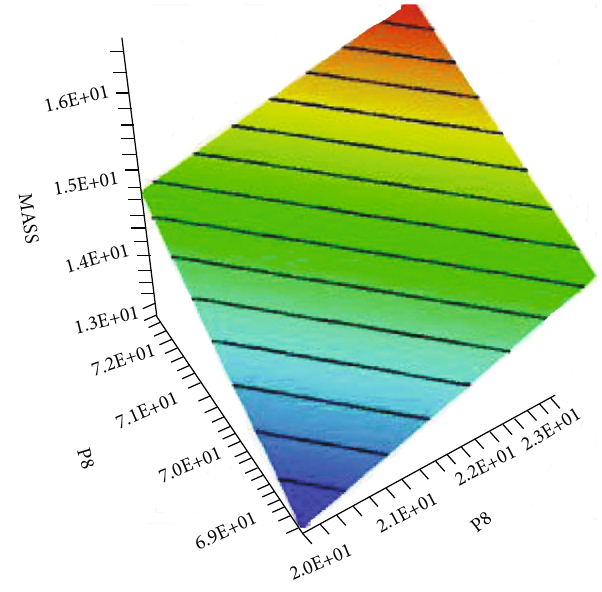
Figure 7: Disc weight response surface.